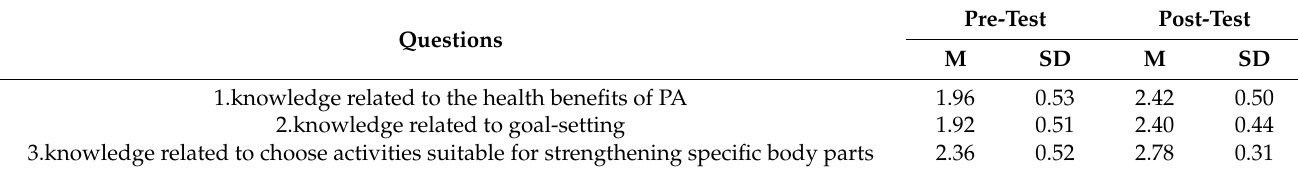
Table 1. Means and standard deviation for students’ answers in the multiple-choice